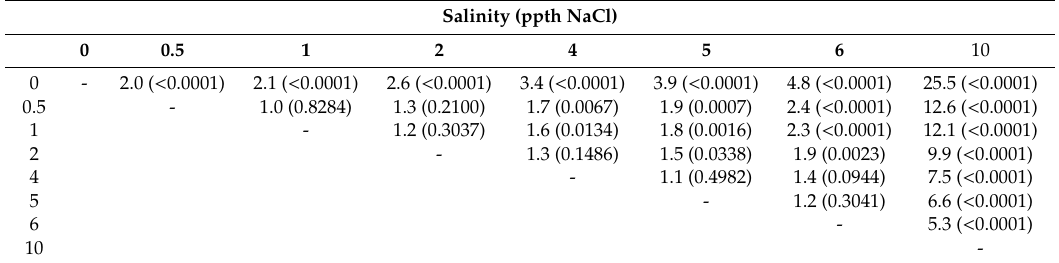
Table 4. Hazard ratios with associated p -values in parentheses for single degree of freedom linear contrasts of Linum arenicola germination following exposure to increasing salinity concentrations. Salinity (ppth